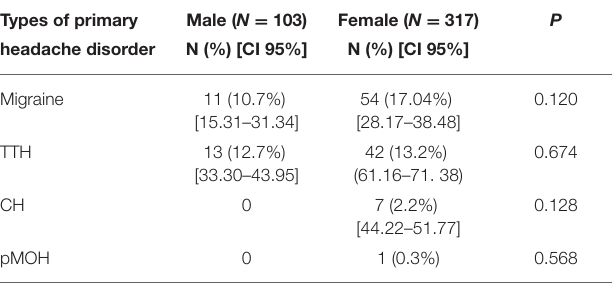
TABLE 6 | One-year prevalence of Types of Primary headache disorders stratified by gender in primary school students ( N = 420). Types of primary